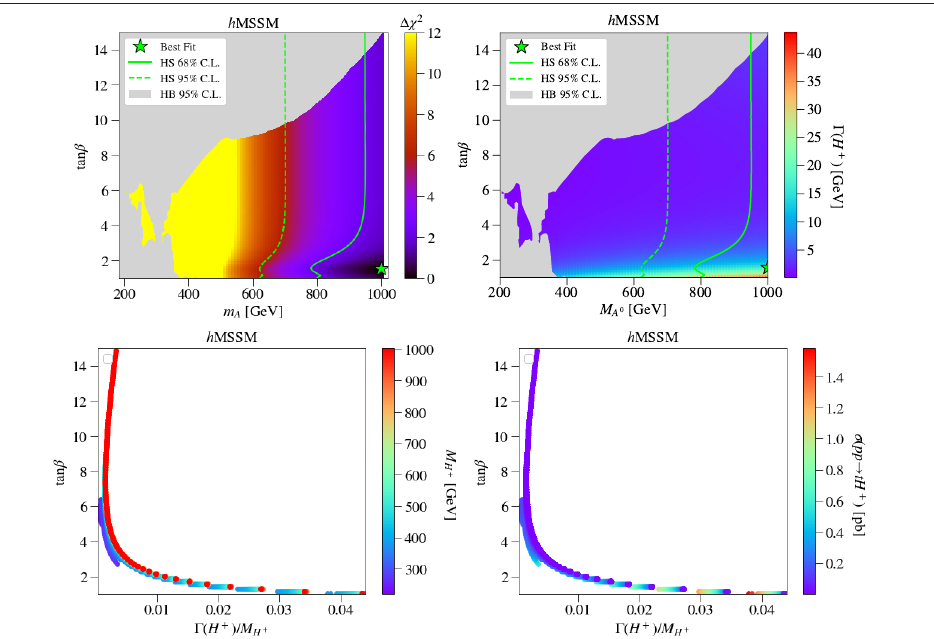
Figure 1. ∆ χ 2 (top-left) and the charged Higgs total width (top-right) in the ( m A ≡ M , tan β ) plane. A 0 ≈ 1 TeV and tan β ≈ 2. The green lines show the exclusion limits The best fit point is located at M A 0 from HiggSignals at 1 σ (solid) and 2 σ (dashed) while the gray area is ruled out by the various LHC searches implemented in HiggsBounds. The ratio Γ H ± / M H ± as a function of the charged Higgs mass is shown in the bottom-left panel while in the bottom-right one it is presented as a function of the charged Higgs production cross